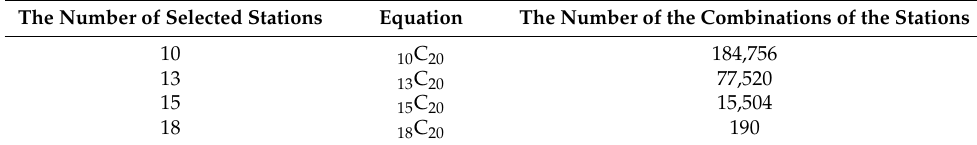
Table 8. The Number of the Possible Combinations of the Selected Stations Out of 20